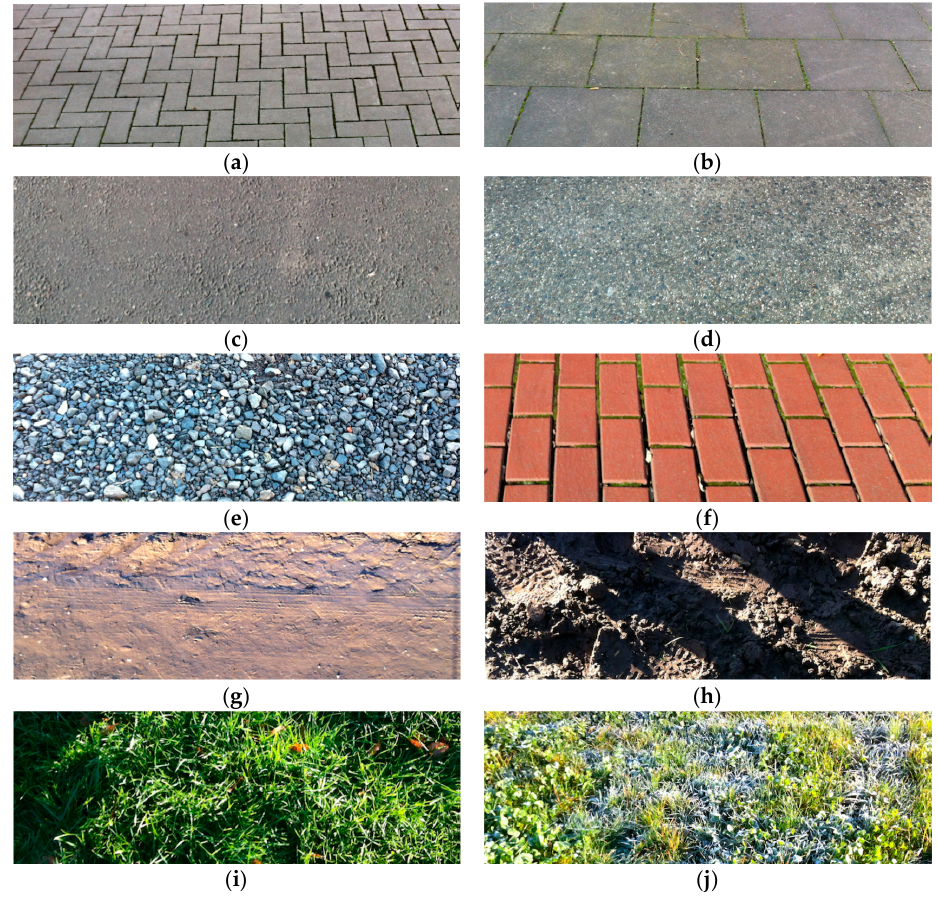
Figure 3. Representation of backgrounds. ( a ) Gray paving stones; ( b ) Stone steps; ( c ) Asphalt; ( d ) Fine chippings; ( e ) Gravel; ( f ) Red paving stones; ( g ) Sandy path; ( h ) Arable land with shadows; ( i ) Grassland; ( j ) Grassland with dew.